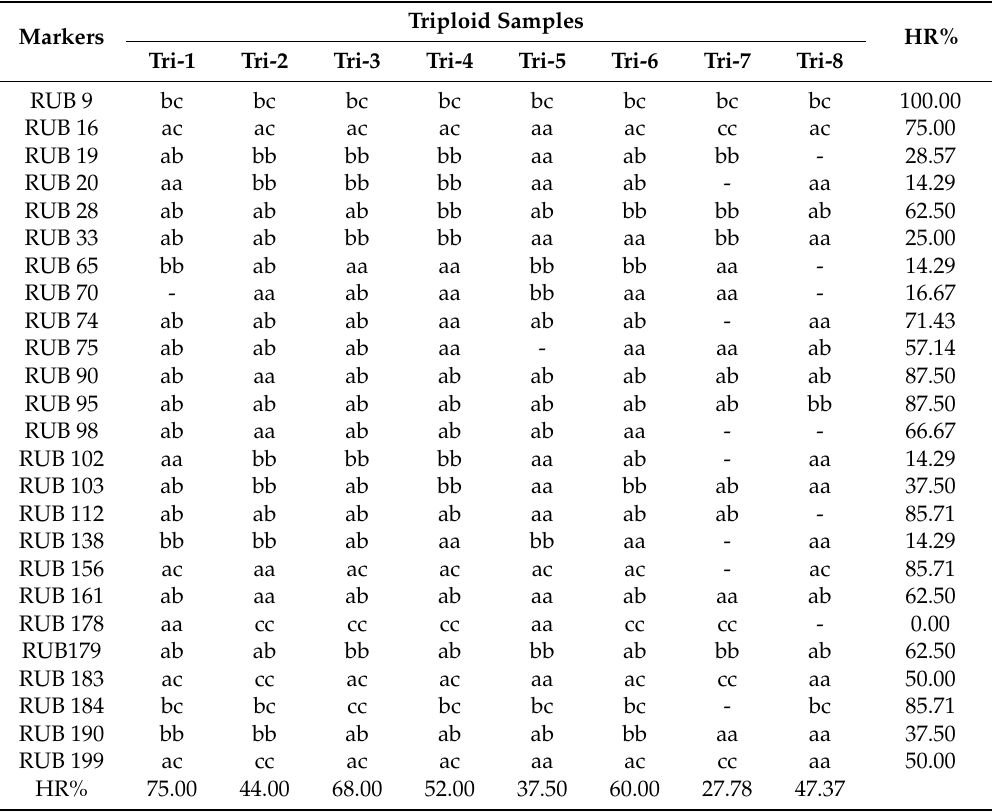
Table 6. Genotypes of 2 n megagametophytes and the rates of maternal HR for each 2 n megagametophyte and each